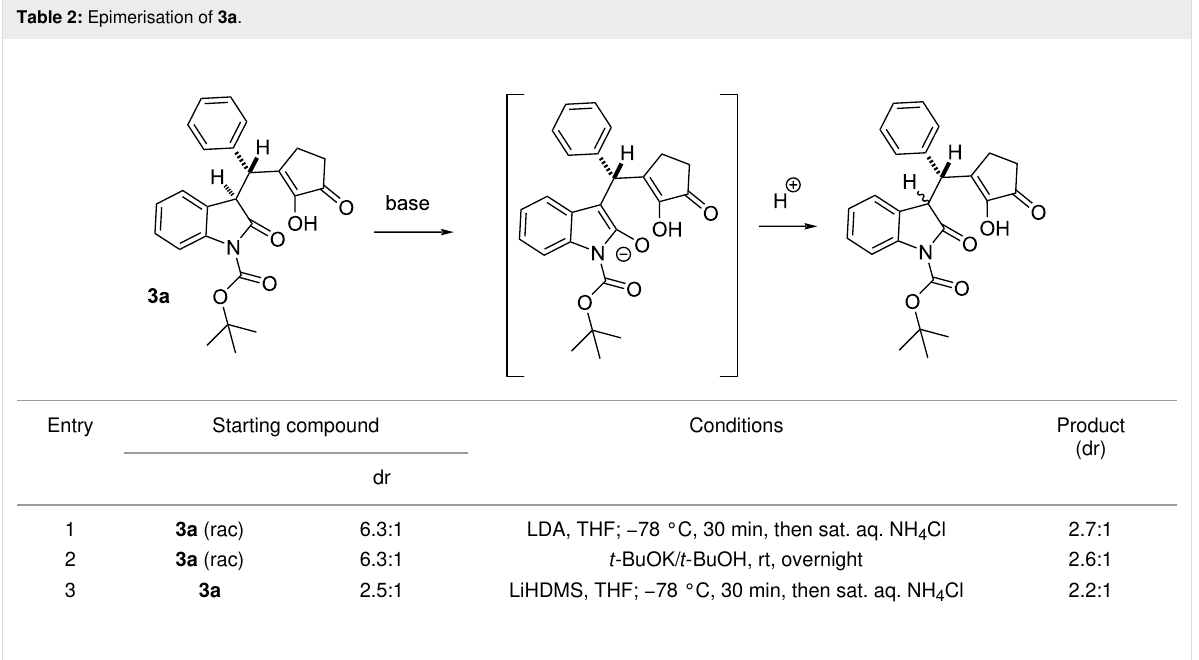
Table 2: Epimerisation of 3a